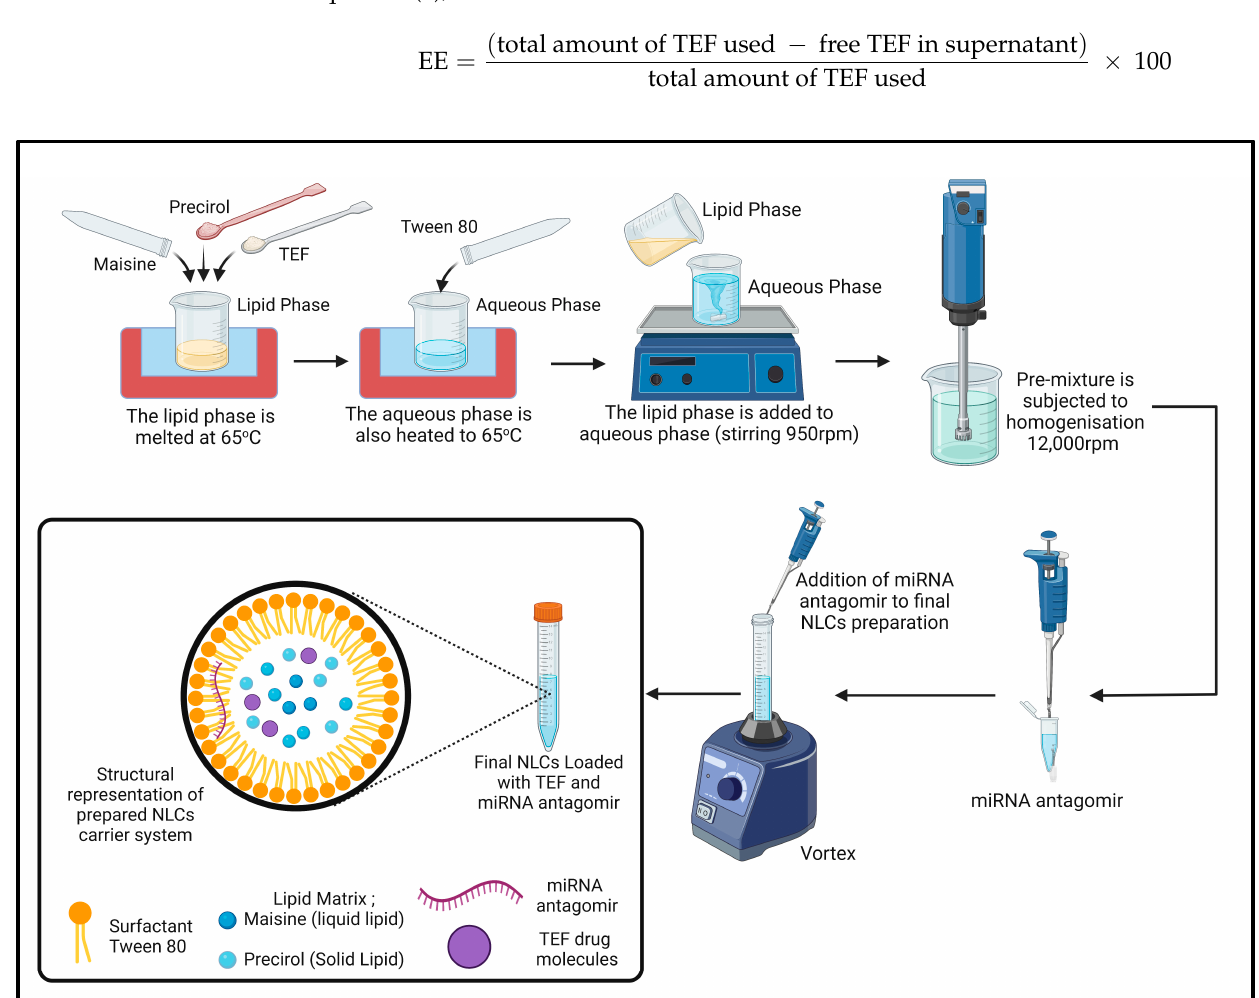
Figure 1. Schematic representation highlighting the steps involved in the preparation of NLCs along with its structural picture.